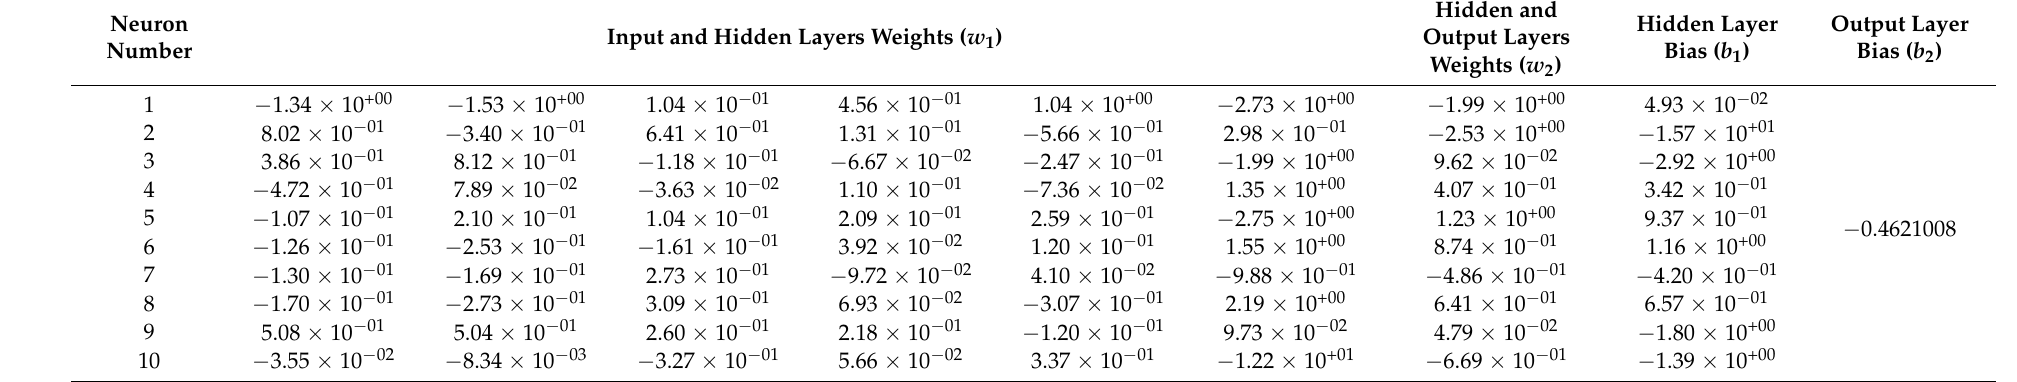
Table 4. Weights and biases for the generated correlation Equation